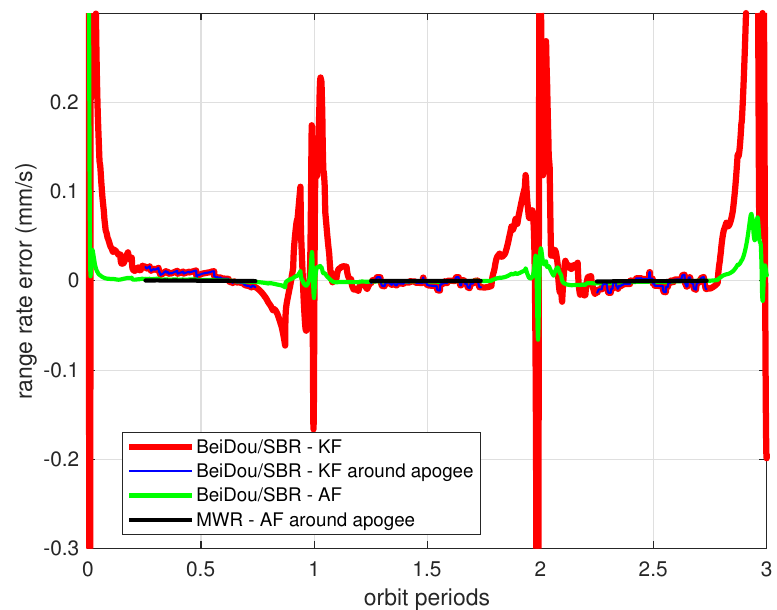
Figure 13. Relative range rate estimation errors from different payloads and filters (refer to Figure 12 for the denotation of color lines).